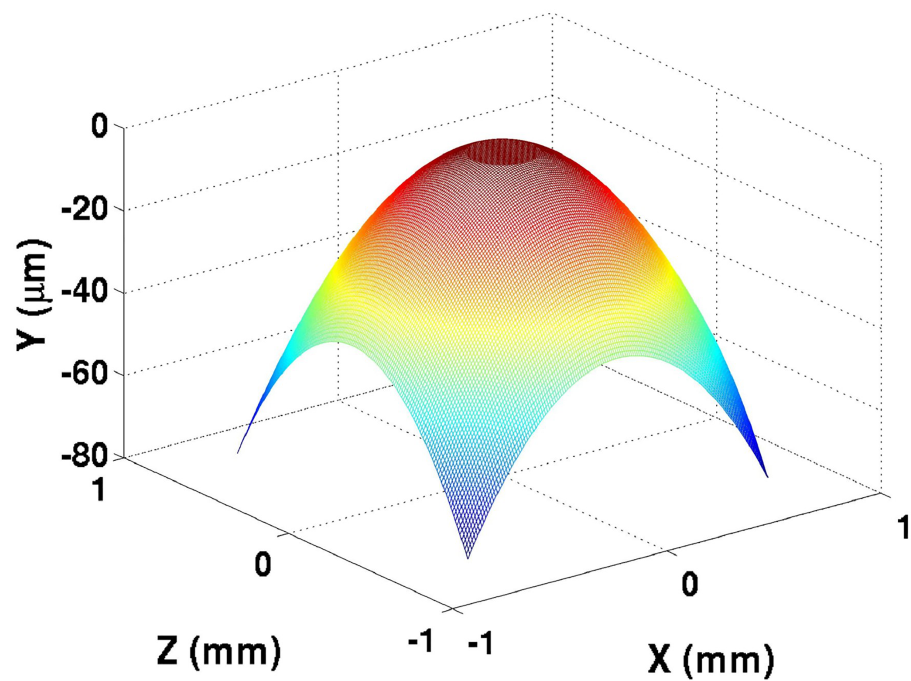
Fig 2. Ball bearing profile subjected to Hertzian deflection for 391 Newtons of load. The Hertzian pressurefunction (Eq 7) was dividedby the Winkler Mattress coefficient (Eq 6), and the deflectionyieldeda flat surface at the region of